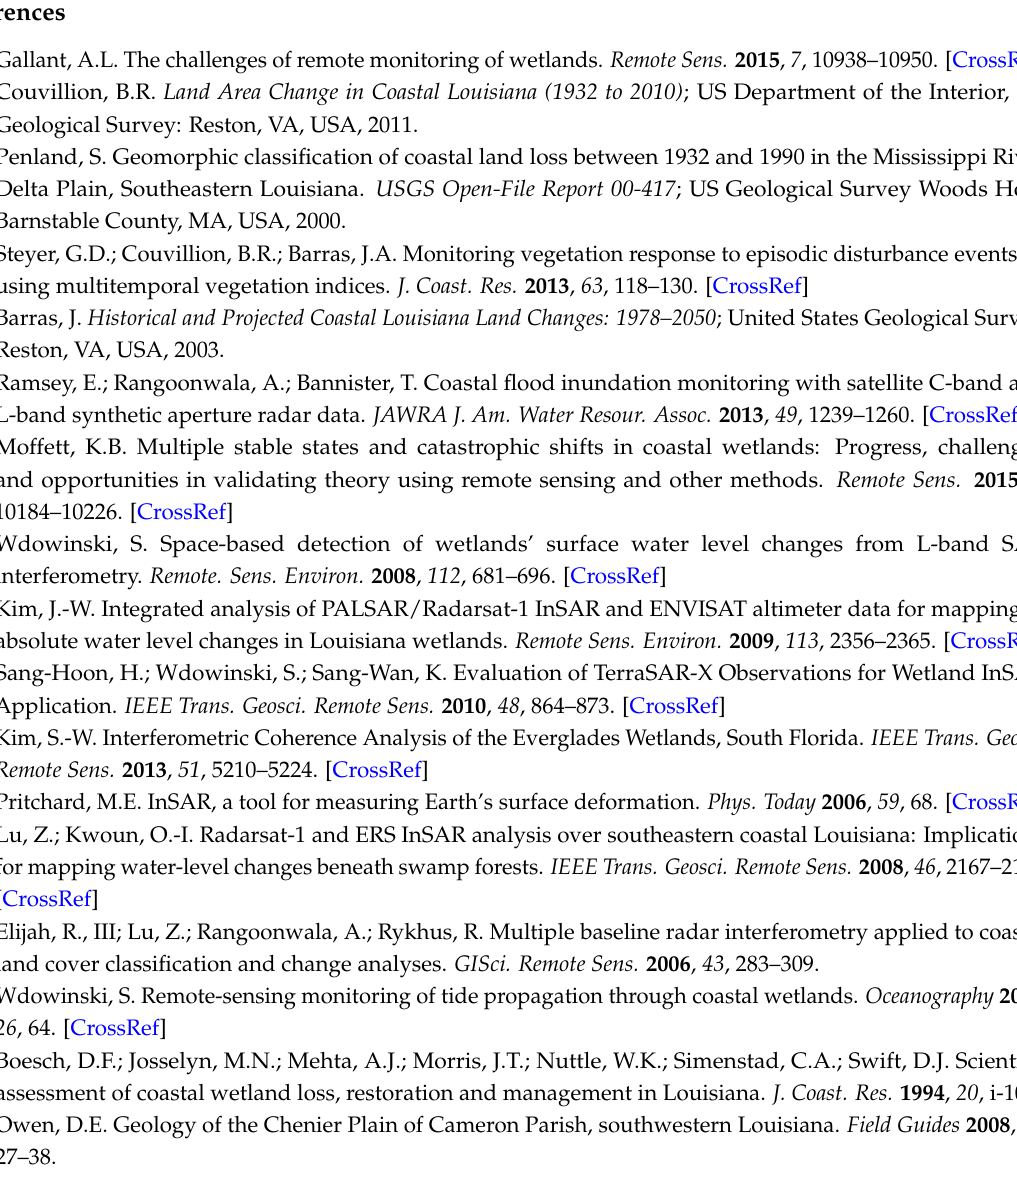
Table S1: Satellite specifications. Figure S1: ALOS 46-92 day interferograms from track